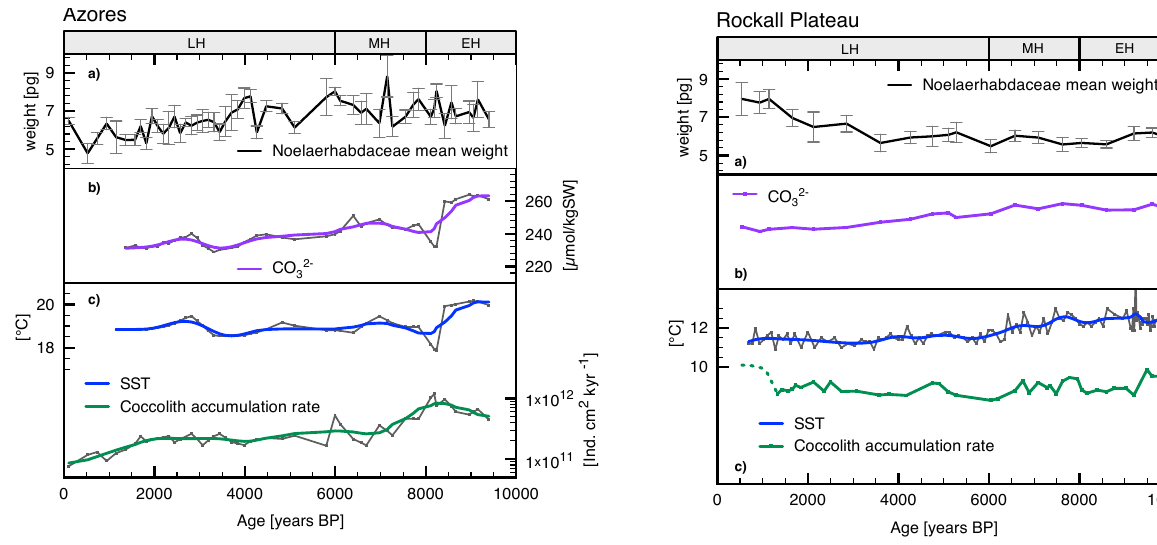
Fig. 10. Rockall Plateau, ODP site 980. (a) Noelaerhabdaceae mean coccolith weight (black line). Error bars indicate 95% confidence intervals of the mean weight. (b) Carbonate ion concentration (pur- ple line) (c) SST (Marchal et al., 2002; blue line) and coccolith ac- cumulation rate (green line). Bold lines are smoothed (by factor of 4), and grey thin lines represent original